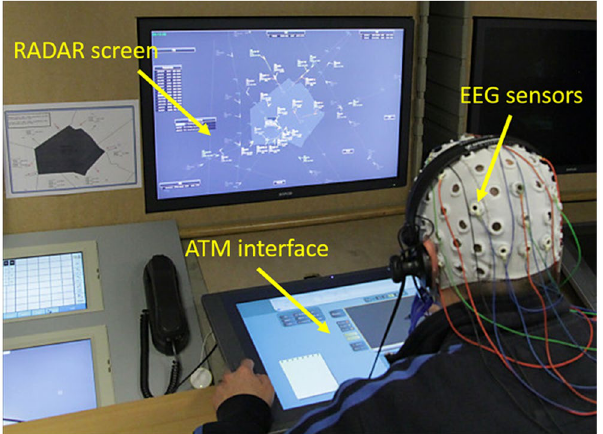
Figure 2. Experimental setup: ATCO working positions developed and hosted at ENAC (Toulouse, France). The ATCO’s brain activity has been recorded continuously during the execution of the ATM scenario, and the SRK events have been marked in order to recognize them within the EEG recording.